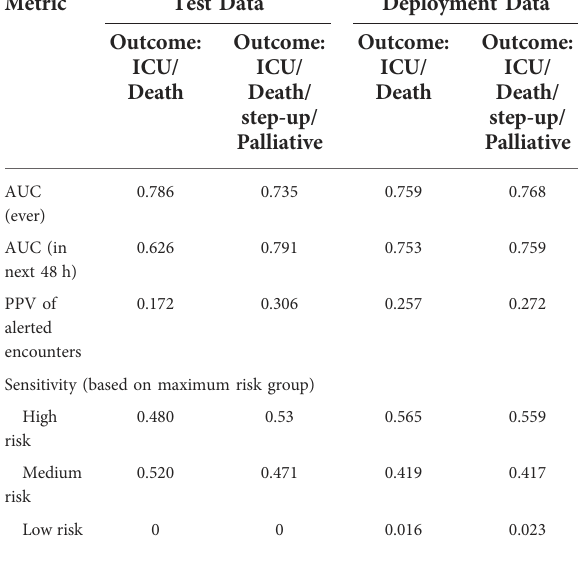
TABLE 2 Performance of the CHARTwatch model in the test data and the deployment data. AUC, PPV, and sensitivity are reported in the test of ICU transfer and in-hospital mortality (Outcome: ICU/Death), as well as in the composite outcome of ICU transfer, in-hospital mortality, step-up unit transfer, and Palliative Care transfer (Outcome: